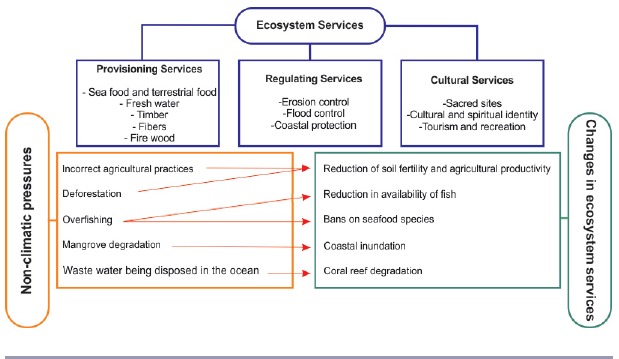
Fig. 4. Relationships (red arrows) between use and delivery of ecosystem services on Ono Island, Fiji. Ecosystem services and links between nonclimatic pressures and changes in services were identified by community